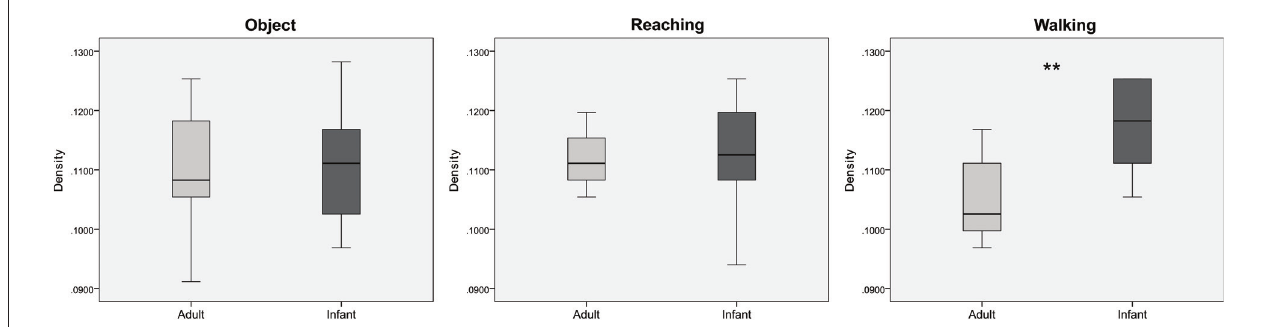
FIGURE 3 | Boxplots showing differences between infants and adults in mean values of density for the three conditions (from left to right: object, reaching, walking) . ** p < 0.01. Whiskers are representing minimum and maximum points of the data.